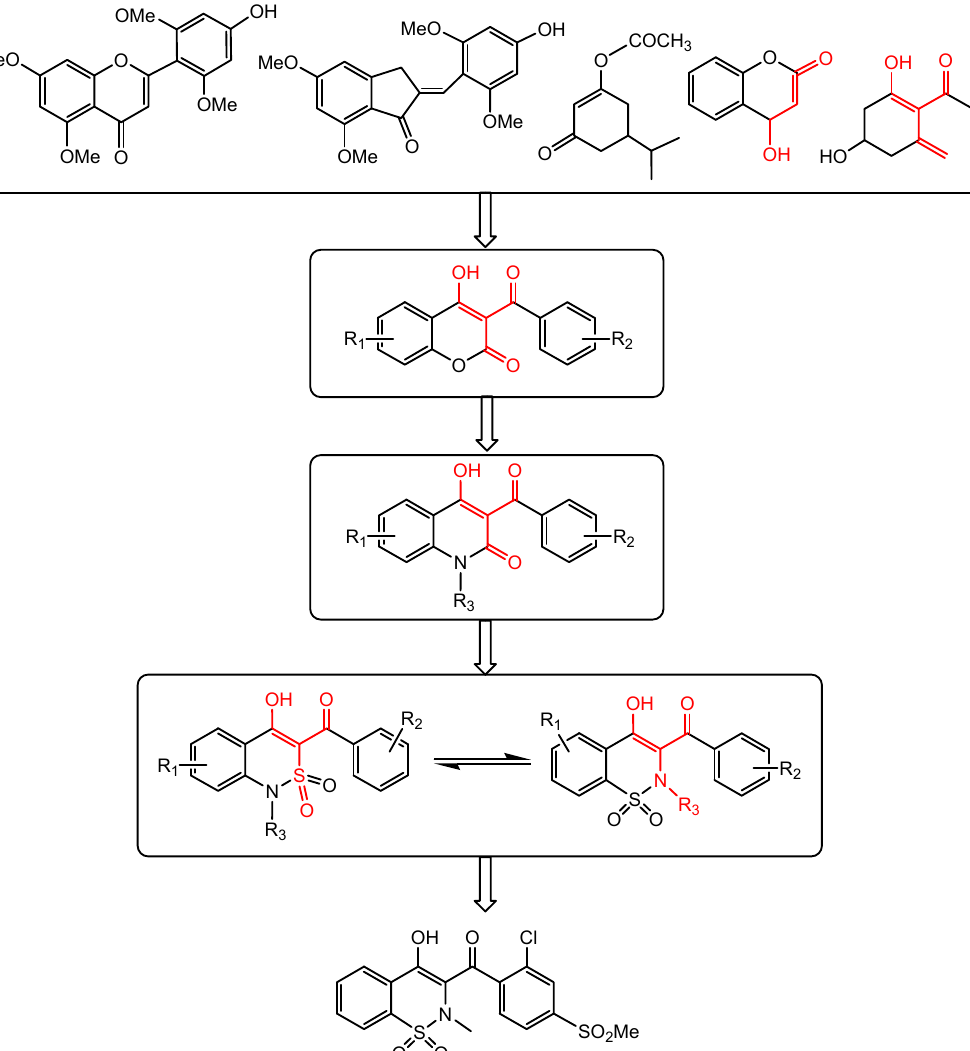
Figure 9. Scheme of design for an allelochemical-based benzothiazine derivative.